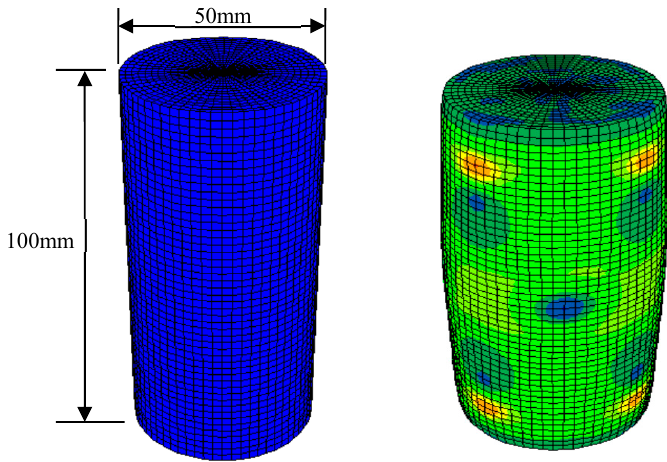
Figure 10. The calculation model and the model after failure.